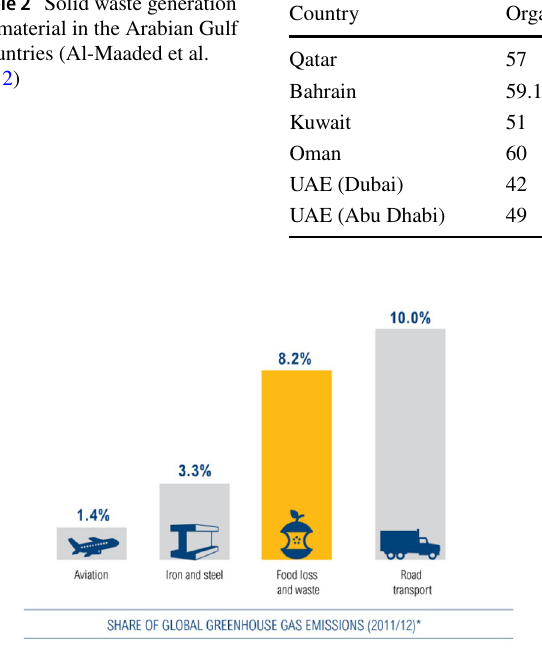
Fig. 9 Regions that generate the most food waste (Recreated